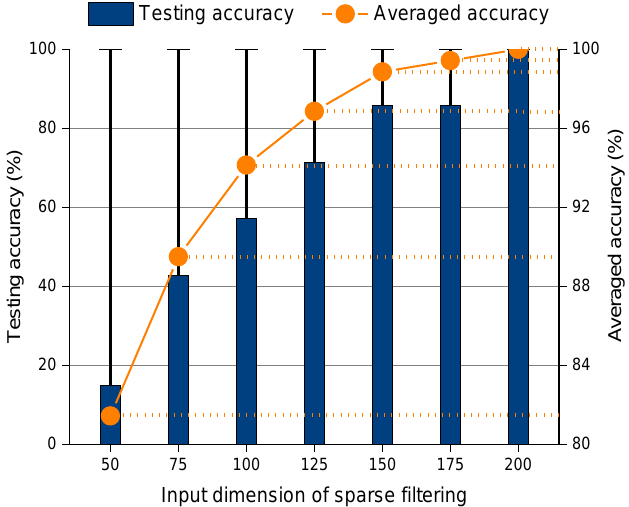
Figure 4. Diagnosis results using various input dimension of harmonic signals group of different frequencies.